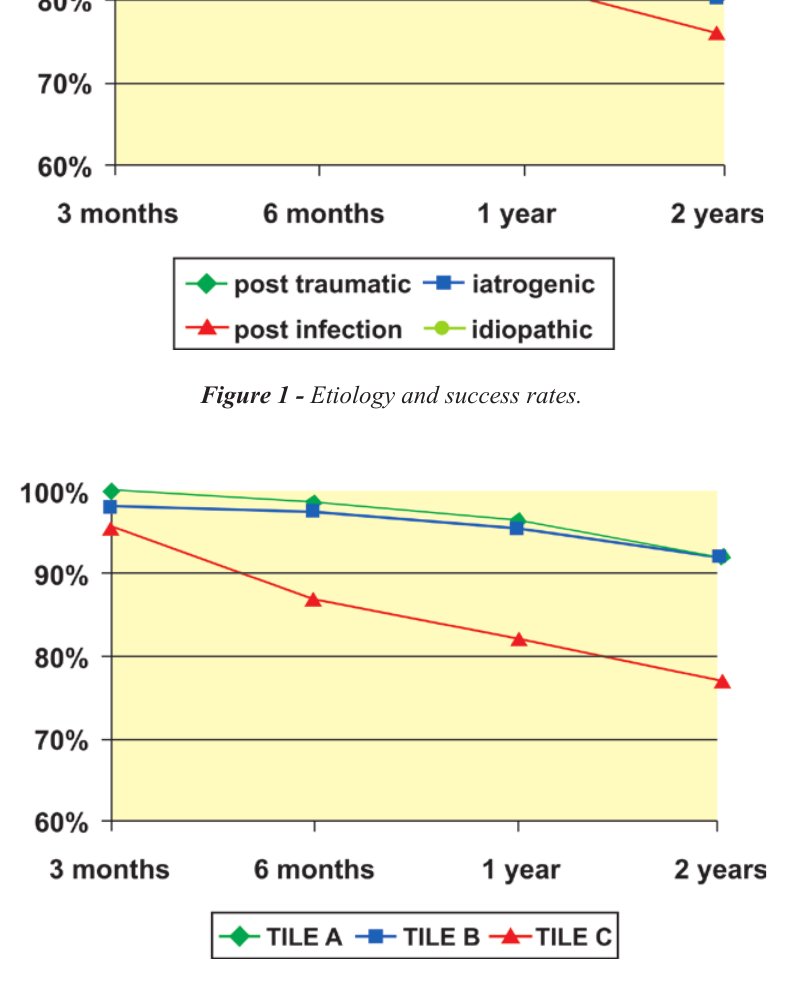
Figure 2 - Success rates based on TILE